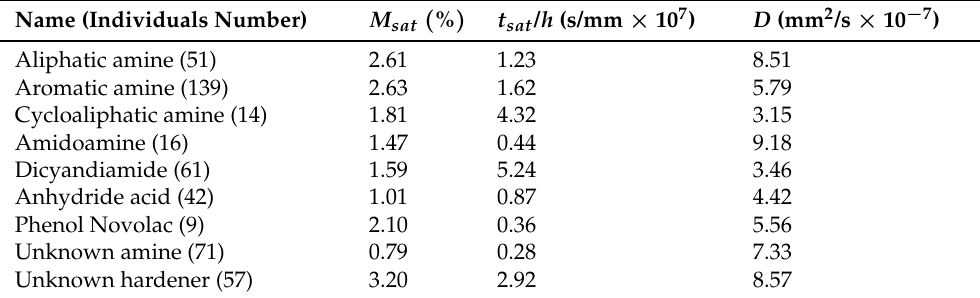
Table 3. Medians of M sat , t sat / h and D as a function of the hardener type. List of hardeners and entire box plots are available as Supplementary Materials (Figures S2 and